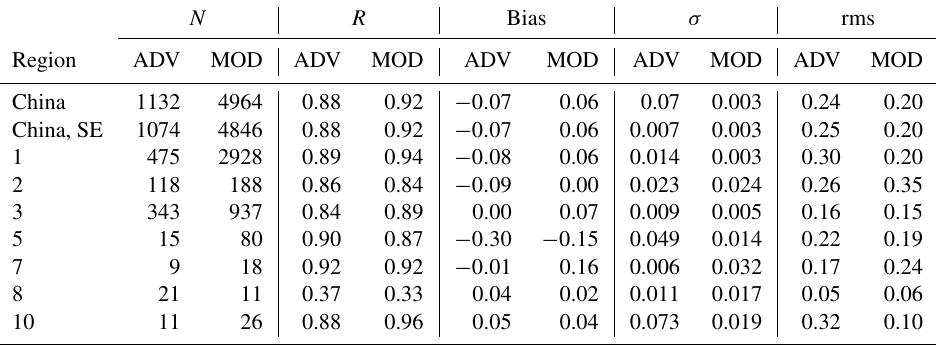
Table 1. AOD validation results (number of points ( N ), correlation coefficient ( R ), bias, standard deviation ( σ ) and root mean square (rms) error) for ADV and MODIS (MOD) obtained for the regions (left column), where AERONET data are available. N